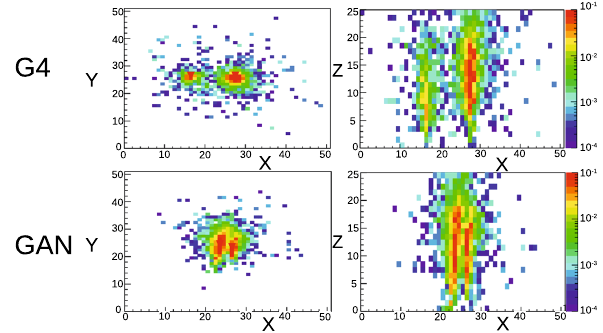
Fig. 19 Graphical projections for the XY and XZ planes for MC events with high discriminator probability of being real images; (top) GEANT4 event; (bottom) GAN